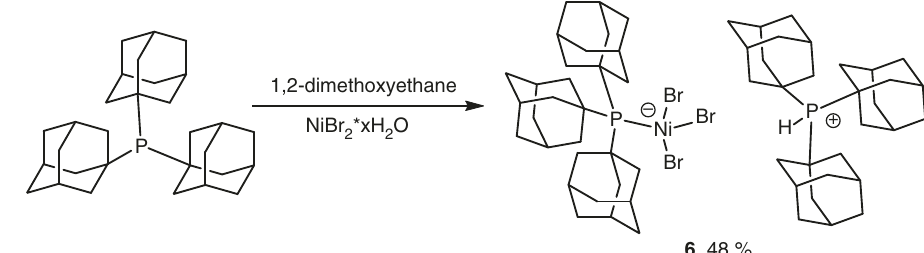
Fig. 2 Synthesis of catalyst 6 . Reaction of tri-1-adamanylphosphine with nickel bromide hydrate in 1,2-dimethoxyethane forms complex 6